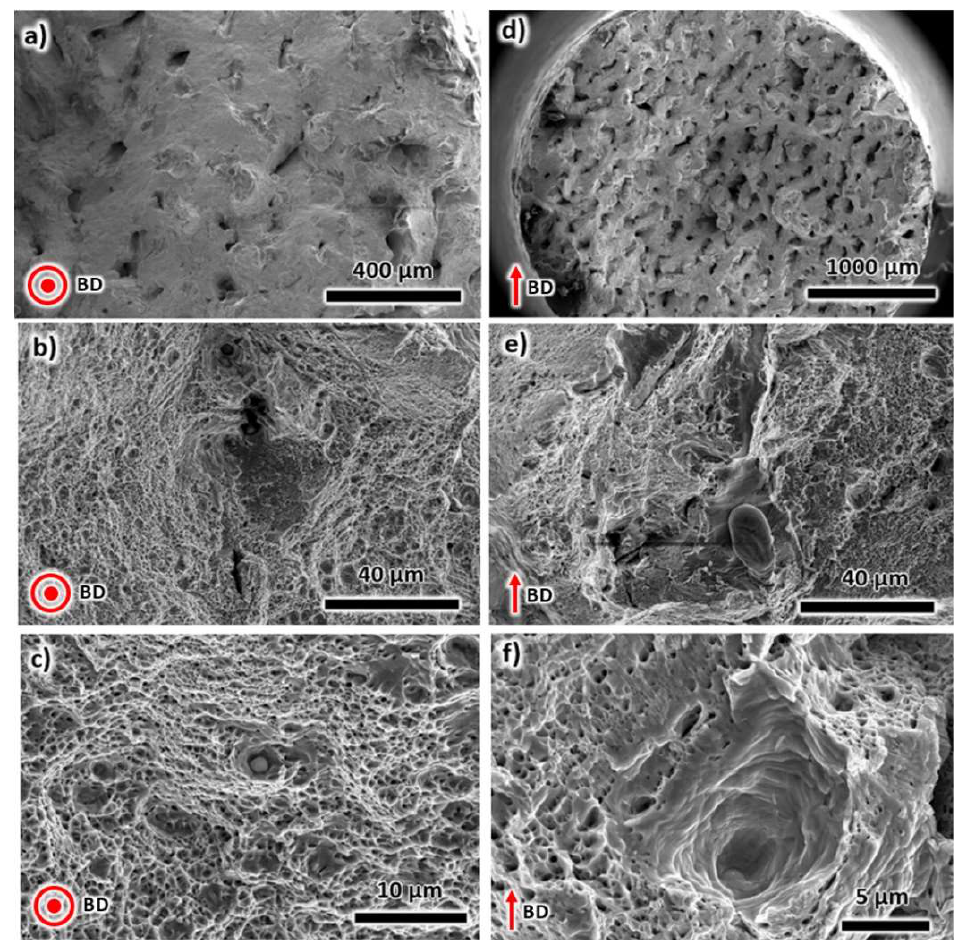
Figure 11. SEM images of the annealing heat-treated sample tensile tested along BD ( a – c ) and TD ( d – f ).